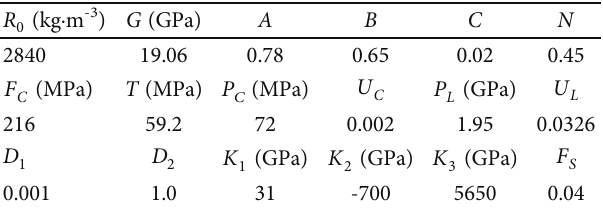
Table 2: Dolomite HJC model parameters.